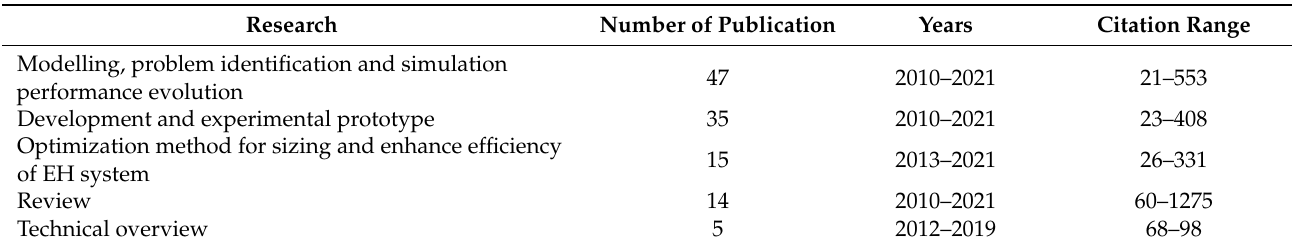
Table 5. Classification of a manuscript based on the type of